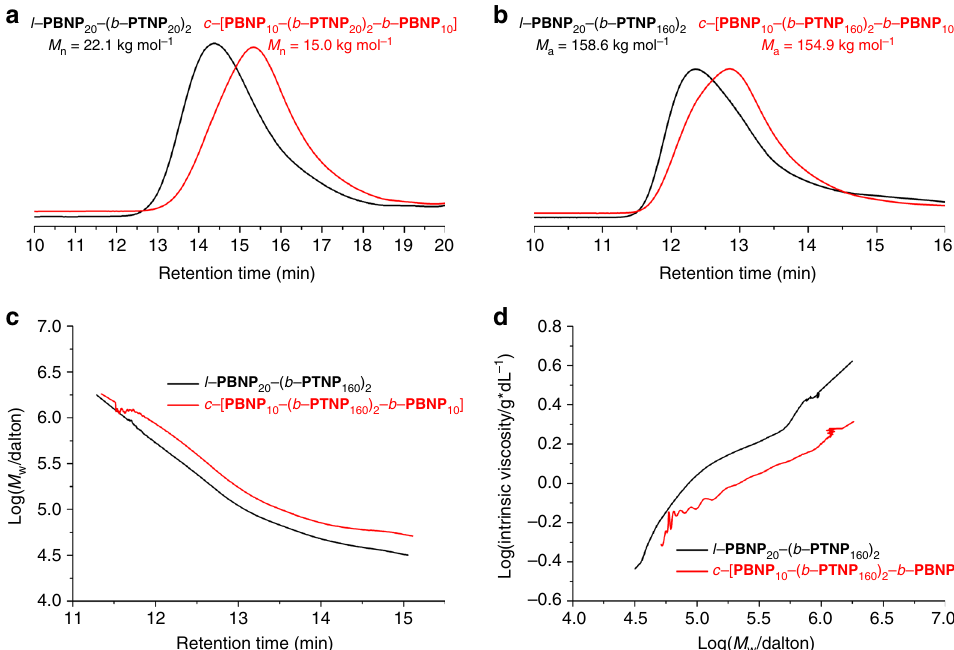
Fig. 4 GPC traces of linear and monocyclic polymers. a Number-average molecular weight ( M n ). b Absolute molecular weight (M a ) vs elution time (eluent = THF; the reported molecular weights were determined by light-scattering methods and are therefore considered absolute). c Plots of log